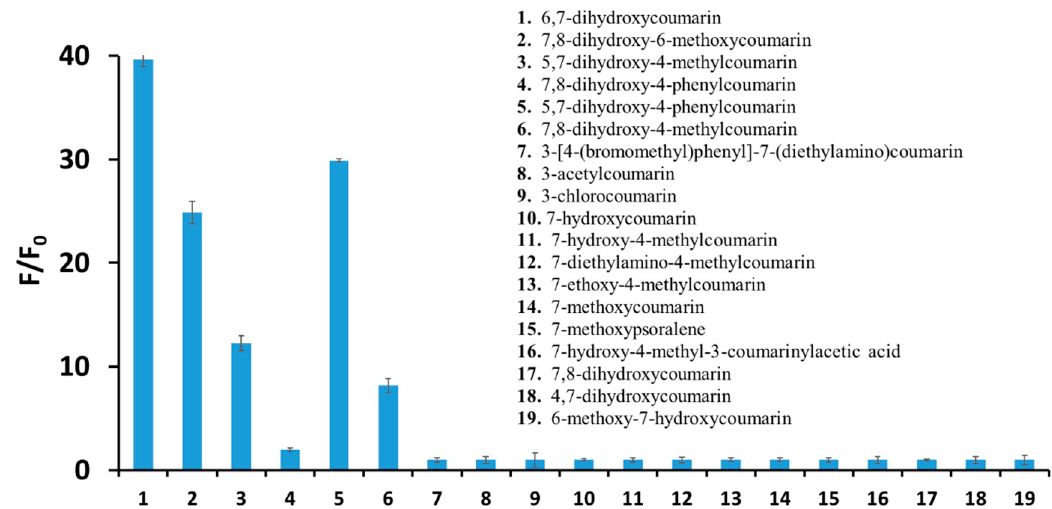
Figure 3. The enhancement of the fluorescence intensity of the coumarins studied (10 µM) in the presence of 4-amino-TEMPO (100 µM) in aqueous solutions. Each experiment was carried out three times, while fluorescence intensity values were the average of 15 measurements.